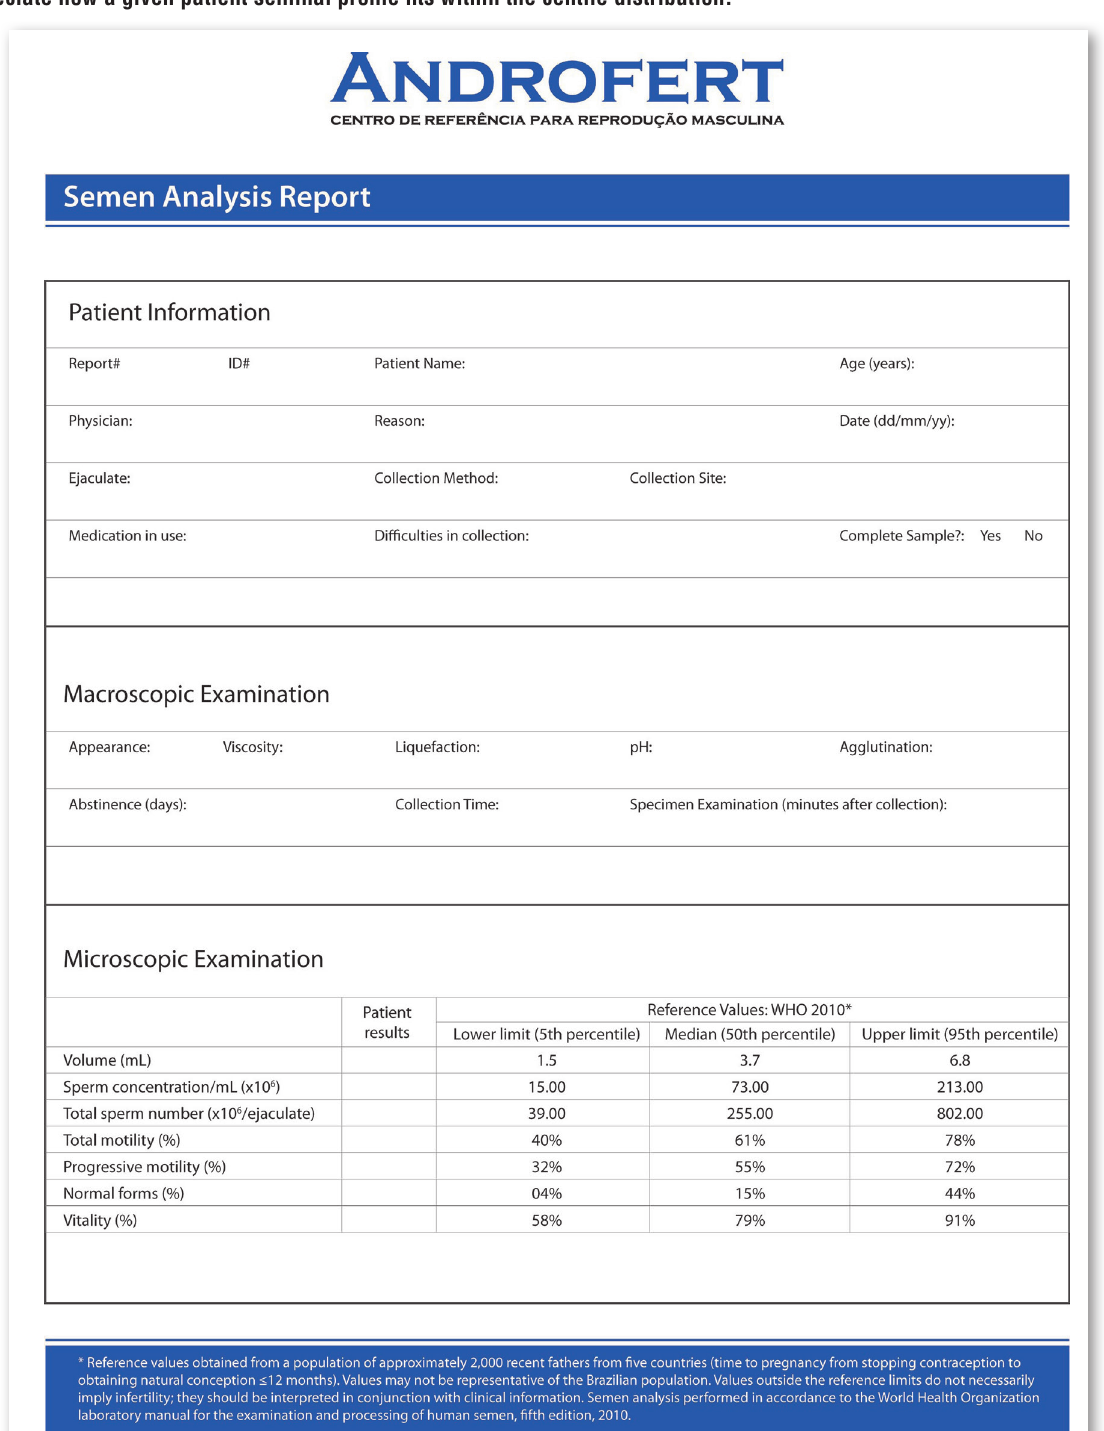
Figure 1 - Modifi ed semen analysis report template. The main difference between the routinely used templates and this one is the inclusion of the ‘centile’ distribution of semen characteristics from the reference population rather than solely the lower thresholds. The patient values (left column) are then compared with the reference limits thus aiding the clinician to appreciate how a given patient seminal profi le fi ts within the centile